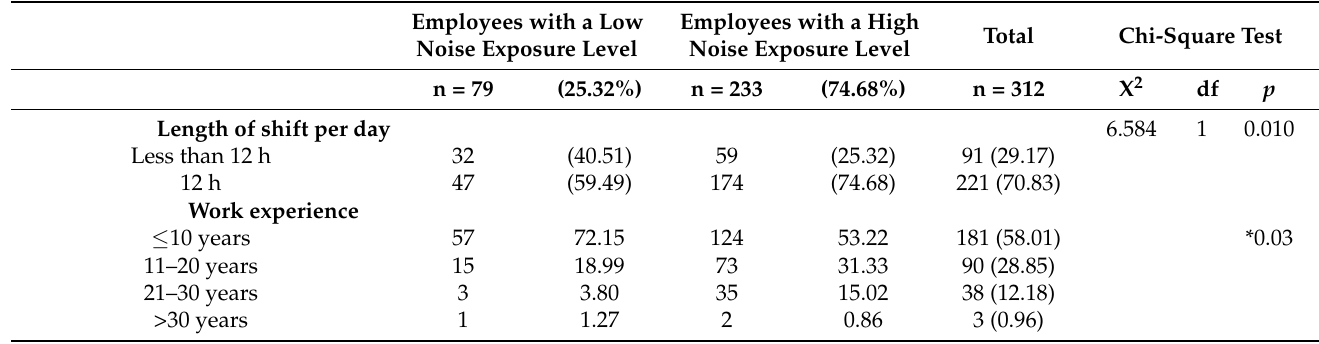
Table 3. The distribution of job-related risk factors in relation to noise exposure